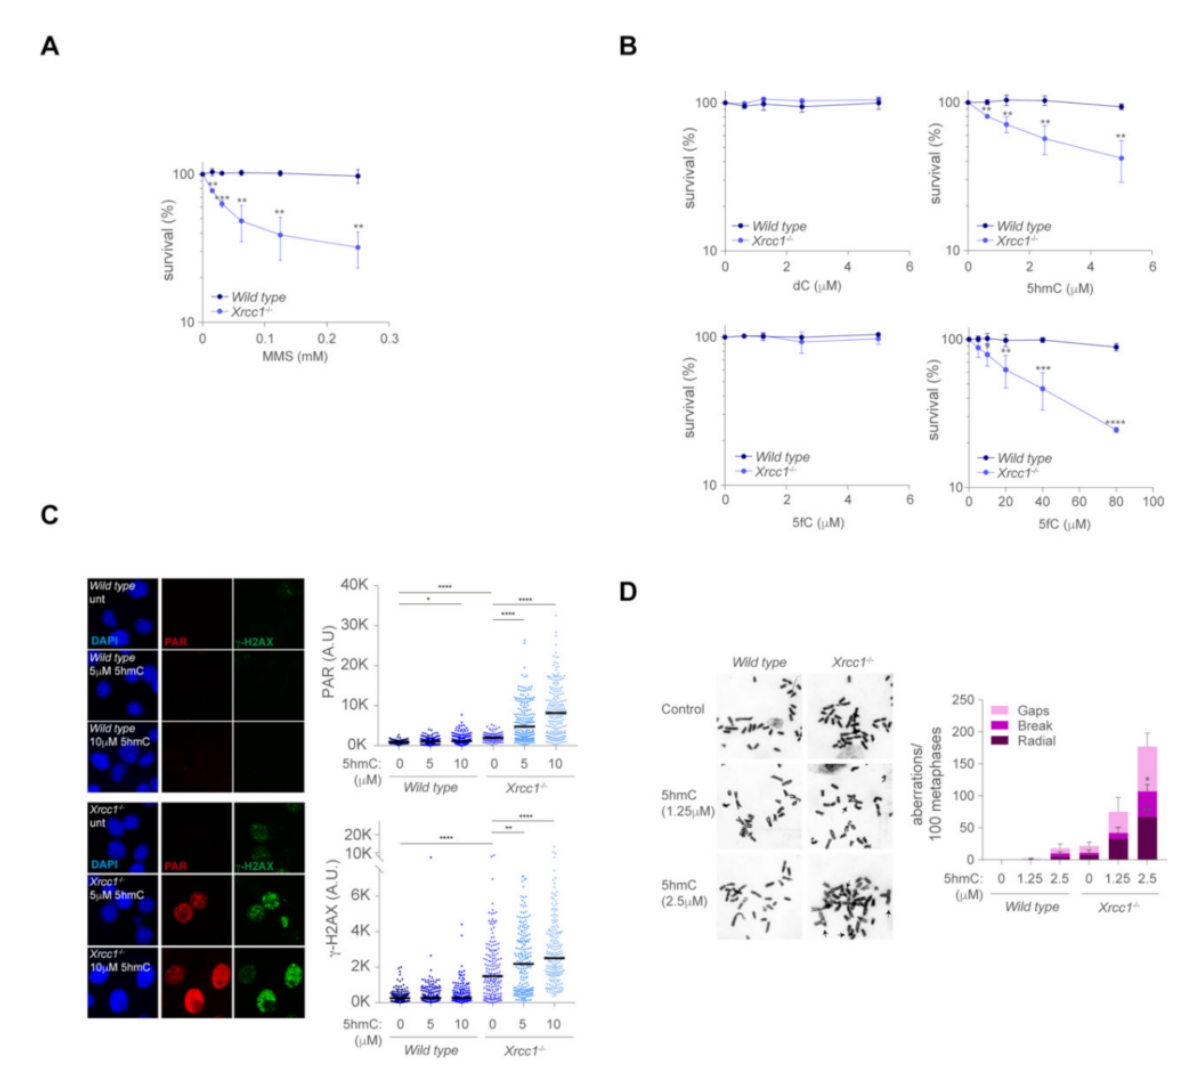
Figure 2. Xrcc1 maintains genome integrity and cell survival upon 5hmC exposure. ( A ) MTT survival assay of wild type and Xrcc1 − / − MEFs treated with methyl methanosulfonate (MMS) at indicated doses for 3 days ( n = 3, mean ± s.e.m). ( B ) MTT survival assay of wild type and Xrcc1 − / − MEFs treated with 5C, 5hmC and 5fC at indicated doses for 3 days ( n = 3, mean ± s.e.m). ( C ) Left, representative immunofluorescence images showing PAR nuclear staining (red) and γ -H2AX (green) of wild type and Xrcc1 − / − MEFs upon exposure to 5hmC (5 µ M and 10 µ M) for 3 h. DAPI (blue) stains nuclear DNA. Right, plot depicting PAR intensity signal per nucleus (top right) and γ -H2AX intensity signal per nucleus (bottom right) ( n = 150 of each of 3 biological replicates, Mann–Whitney test; central line represents median value). ( D ) Left, representative images of chromosome aberrations from wild type and Xrcc1 − / − MEFs following 5hmC treatment (1.25 µ M and 2.5 µ M) for two cell cycles. Right, a bar plot of breakdown of the different types of chromosomal aberrations ( n = 50 of each of 3 biological replicates, Student’s t -test; bar represents mean ±